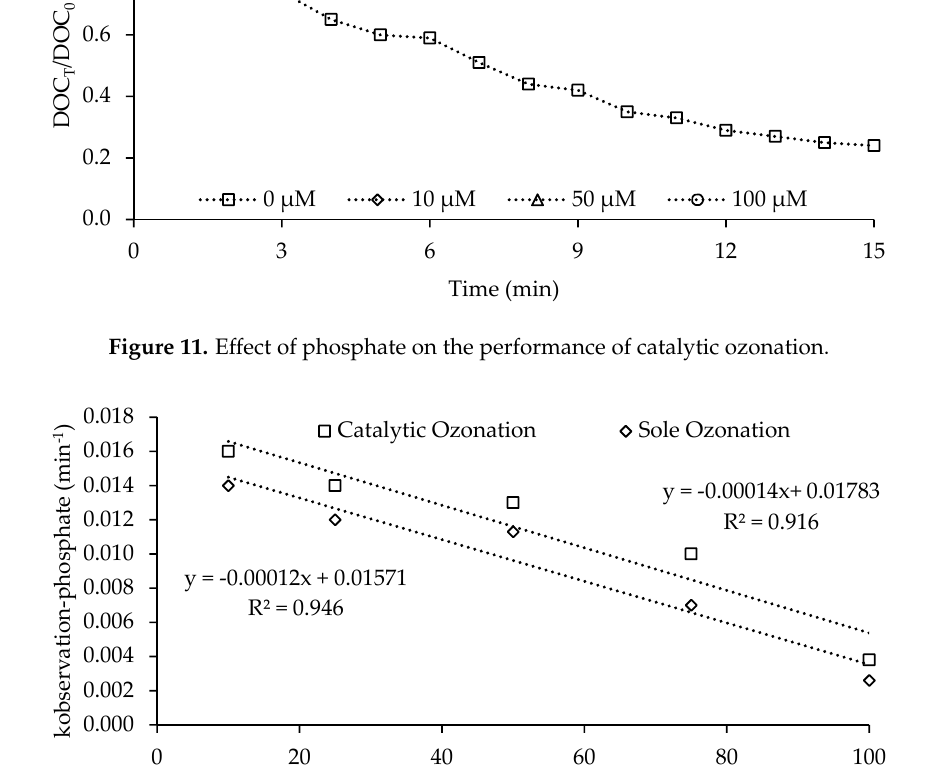
Figure 12. Phosphate concentration and linearity of reaction rate constants.